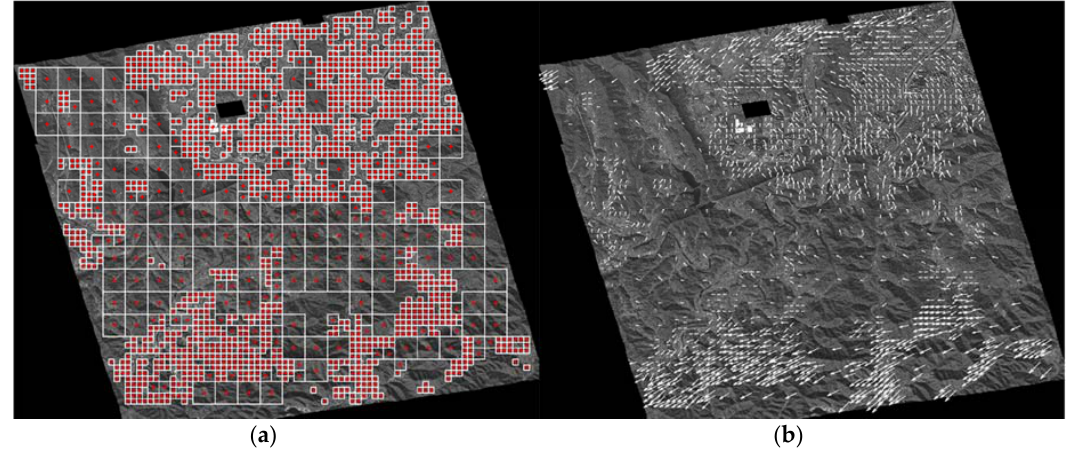
Figure 8. Extracted corresponding points (CPs) from the K3 ‐ 1 and K3 ‐ 2 image pair. ( a ) Determined segments are expressed as white rectangles, and corresponding CPs, which are in the centroids of the segments, are marked as red points; ( b ) Location differences between CPs of the reference and sensed images are indicated as arrows.